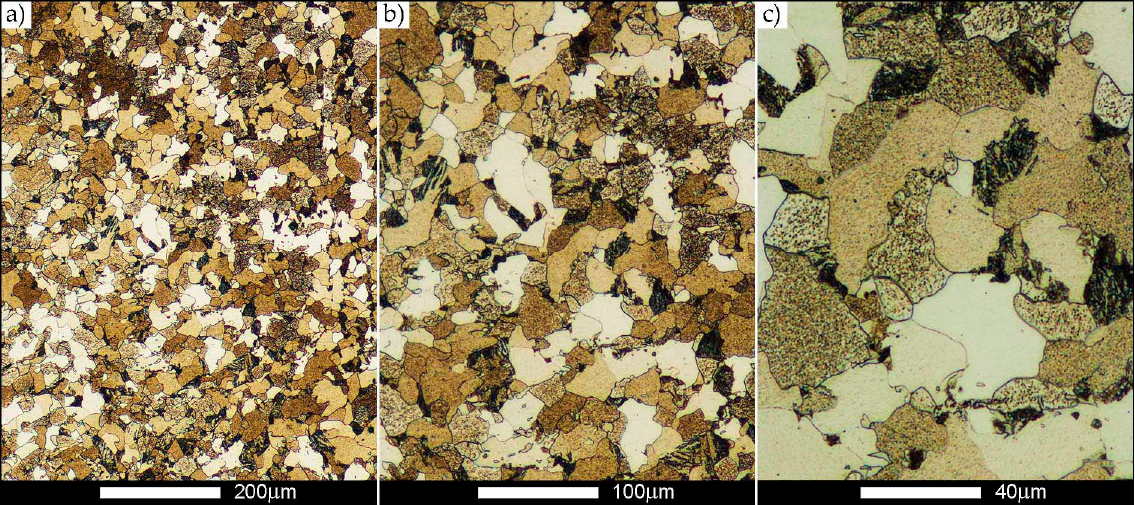
Figure 51. Welded joint microstructure of Hardox 450 steel in the normalised state with visible prior austenite grain boundaries—FL zone shown in Figure 2. ( a ) 100 × ; ( b ) 200 × ; ( c ) 500 × .